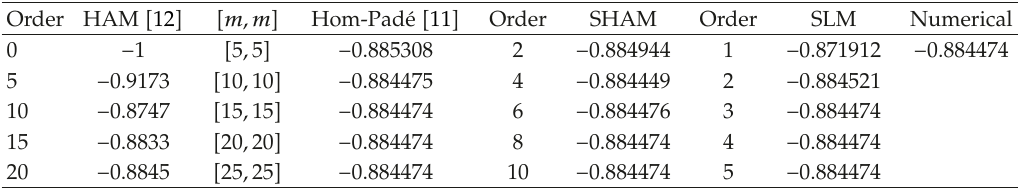
Table 1: Comparison of H (cid:6) ∞ (cid:7) at di ff erent orders of the HAM (cid:3) 12 (cid:4) , Homotopy-Pad´e (cid:3) 11 (cid:4) , SHAM, and the SLM approximations when (cid:2) (cid:10) − 1, L (cid:10) 20, and N (cid:10) 60. Order HAM (cid:3) 12